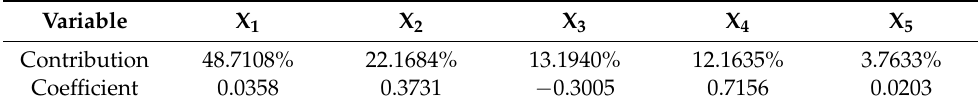
Table 3. Variable contribution and transformation